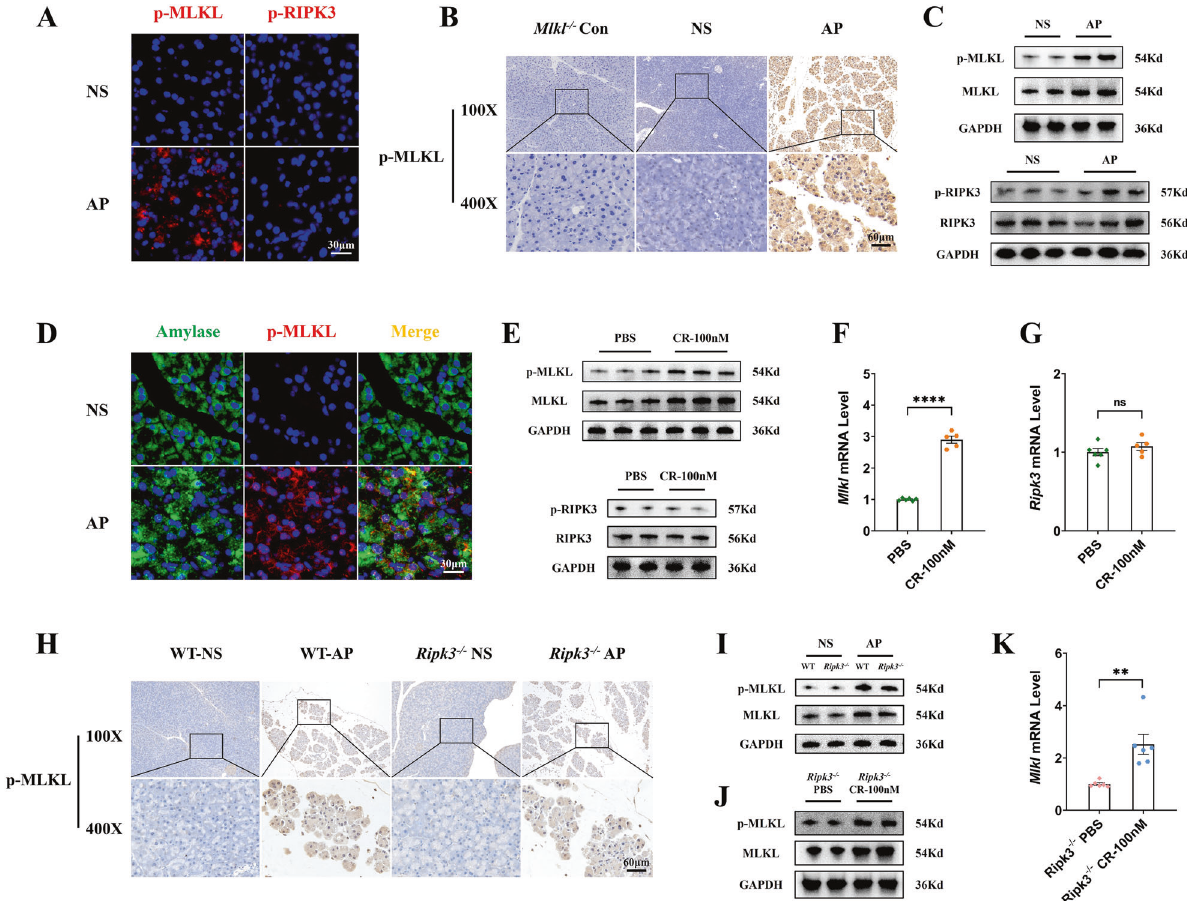
Fig. 1 The expression of p-MLKL was upregulated in the pancreas of mice with AP and in cerulein-stimulated pancreatic acinar cells in a Ripk3 -independent manner. A Immuno fl uorescence staining of p-MLKL (red) and p-RIPK3 (red) in the pancreas of mice ( n = 3). B Immunohistochemical staining of p-MLKL in the pancreas of mice ( n = 3). C Western blot of p-RIPK3, RIPK3, p-MLKL and MLKL in the pancreas of mice. GAPDH was used as the loading control ( n = 6). D Immuno fl uorescence staining of amylase (green) colocalized with p-MLKL (red) in the pancreas of mice ( n = 3). E Western blot of p-RIPK3, RIPK3, p-MLKL and MLKL in pancreatic acinar cells. GAPDH was used as the loading control ( n = 7). F , G mRNA expression of Mlkl and Ripk3 in pancreatic acinar cells, data were normalized to GAPDH ( n = 5 – 6). H Immunohistochemical staining of p-MLKL in the pancreas of WT and Ripk3 -/- mice ( n = 6). I Western blot of p-MLKL and MLKL in the pancreas of WT and Ripk3 -/- mice. GAPDH was used as the loading control ( n = 6). J Western blot of p-MLKL and MLKL in pancreatic acinar cells isolated from Ripk3 -/- mice. GAPDH was used as the loading control ( n = 7). K mRNA expression of Mlkl in pancreatic acinar cells isolated from Ripk3 -/- mice. Data were normalized to GAPDH ( n = 6). Values are shown as the means ± SEMs. ns, not signi fi cant; * P < 0.05; ** P < 0.01; *** P < 0.001; **** P < 0.0001. WT wild type, NS normal saline, AP acute pancreatitis, CR vitro neutralization of CXCL10 impaired the pro-M1 ability of the conditioned medium of cerulein-treated pancreatic acinar cells, whereas in vivo neutralization of CXCL10 reduced the polarization of pancreatic macrophages toward M1 and the severity of AP in mice.